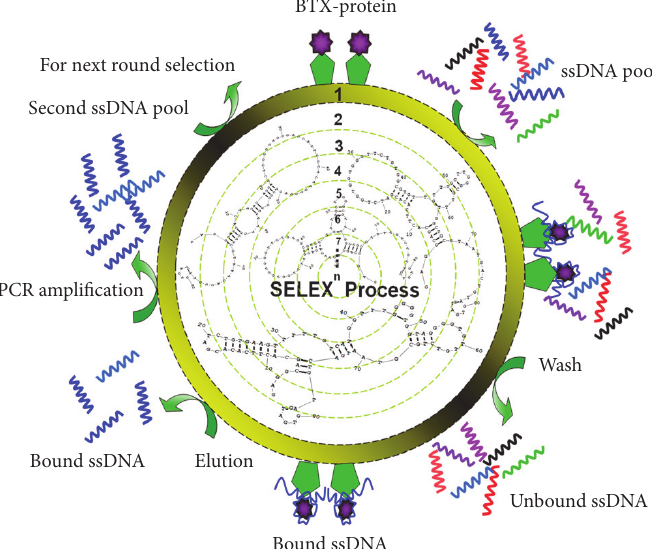
Scheme 1: Schematic representation of the SELEX process used to select the